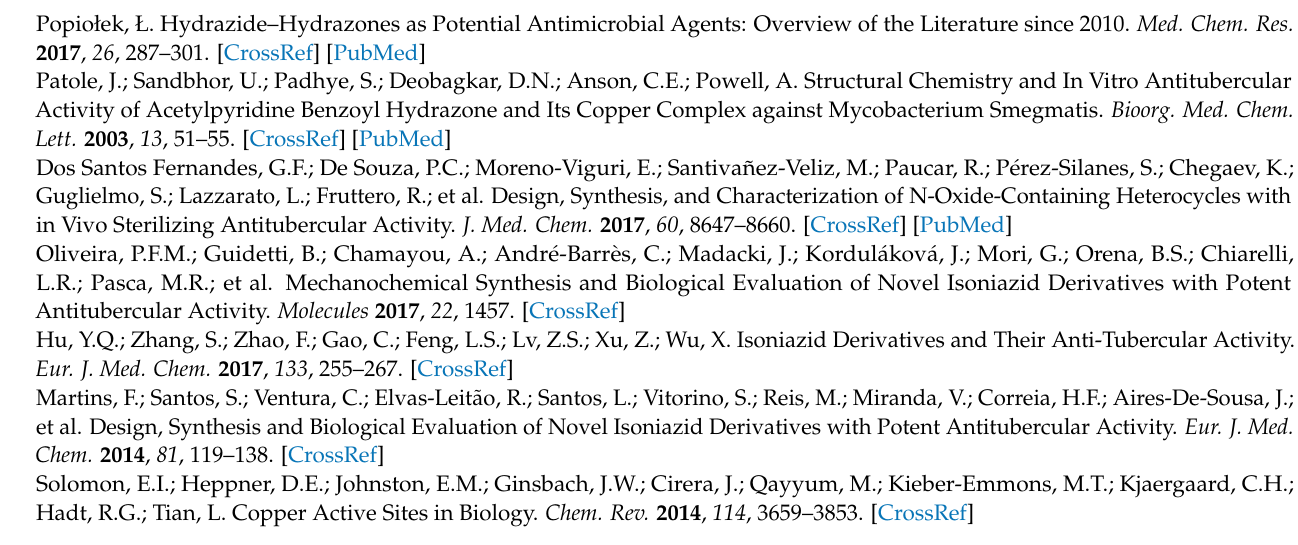
Figure S2: System of the H bonds for 1 ∞ { [ Cu L Cl ] · 0.5H 2 O } , Figure S3: Isomeric conversion of the LH ligand, Figures S4–S6: Mass spectra of the corresponding compounds, Figures S7–S11: Structure and formation energy (in atomic units, a.u.) of LH isomers optimized on the B3LYP/def2-TZVPP level, accounting for the solvent effects in the C-PCM model and dispersion correction (D3BJ); Figures S12 and S13: Structure of the Cu L complex and selected interatomic distances optimized on the B3LYP/def2-TZVPP level, accounting for the solvent effects in the C-PCM model and